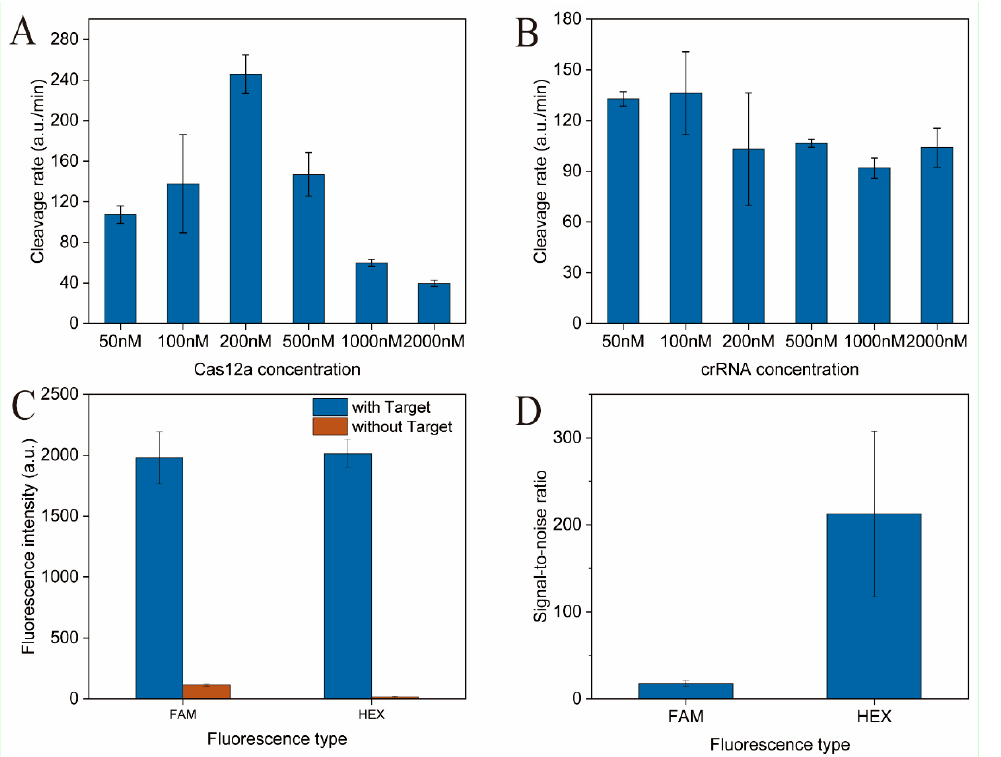
Figure 3. CRISPR-Cas12a detection system optimization for Lactobacillus panis . ( A ) Cleavage rate at different working concentrations of Cas12a. ( B ) Cleavage rate at different working concentrations of crRNA. ( C ) Fluorescence intensity using different probes. ( D ) Signal-to-noise ratio using different ssDNA probes.